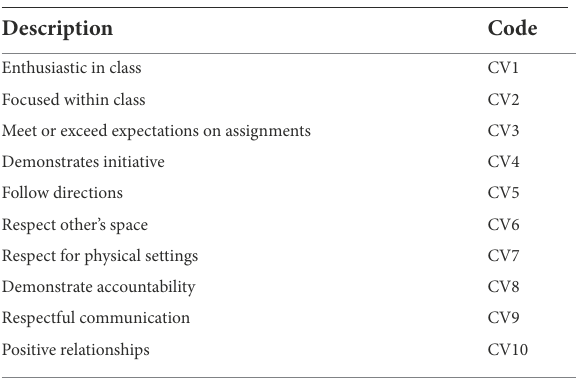
TABLE 1 Reported core